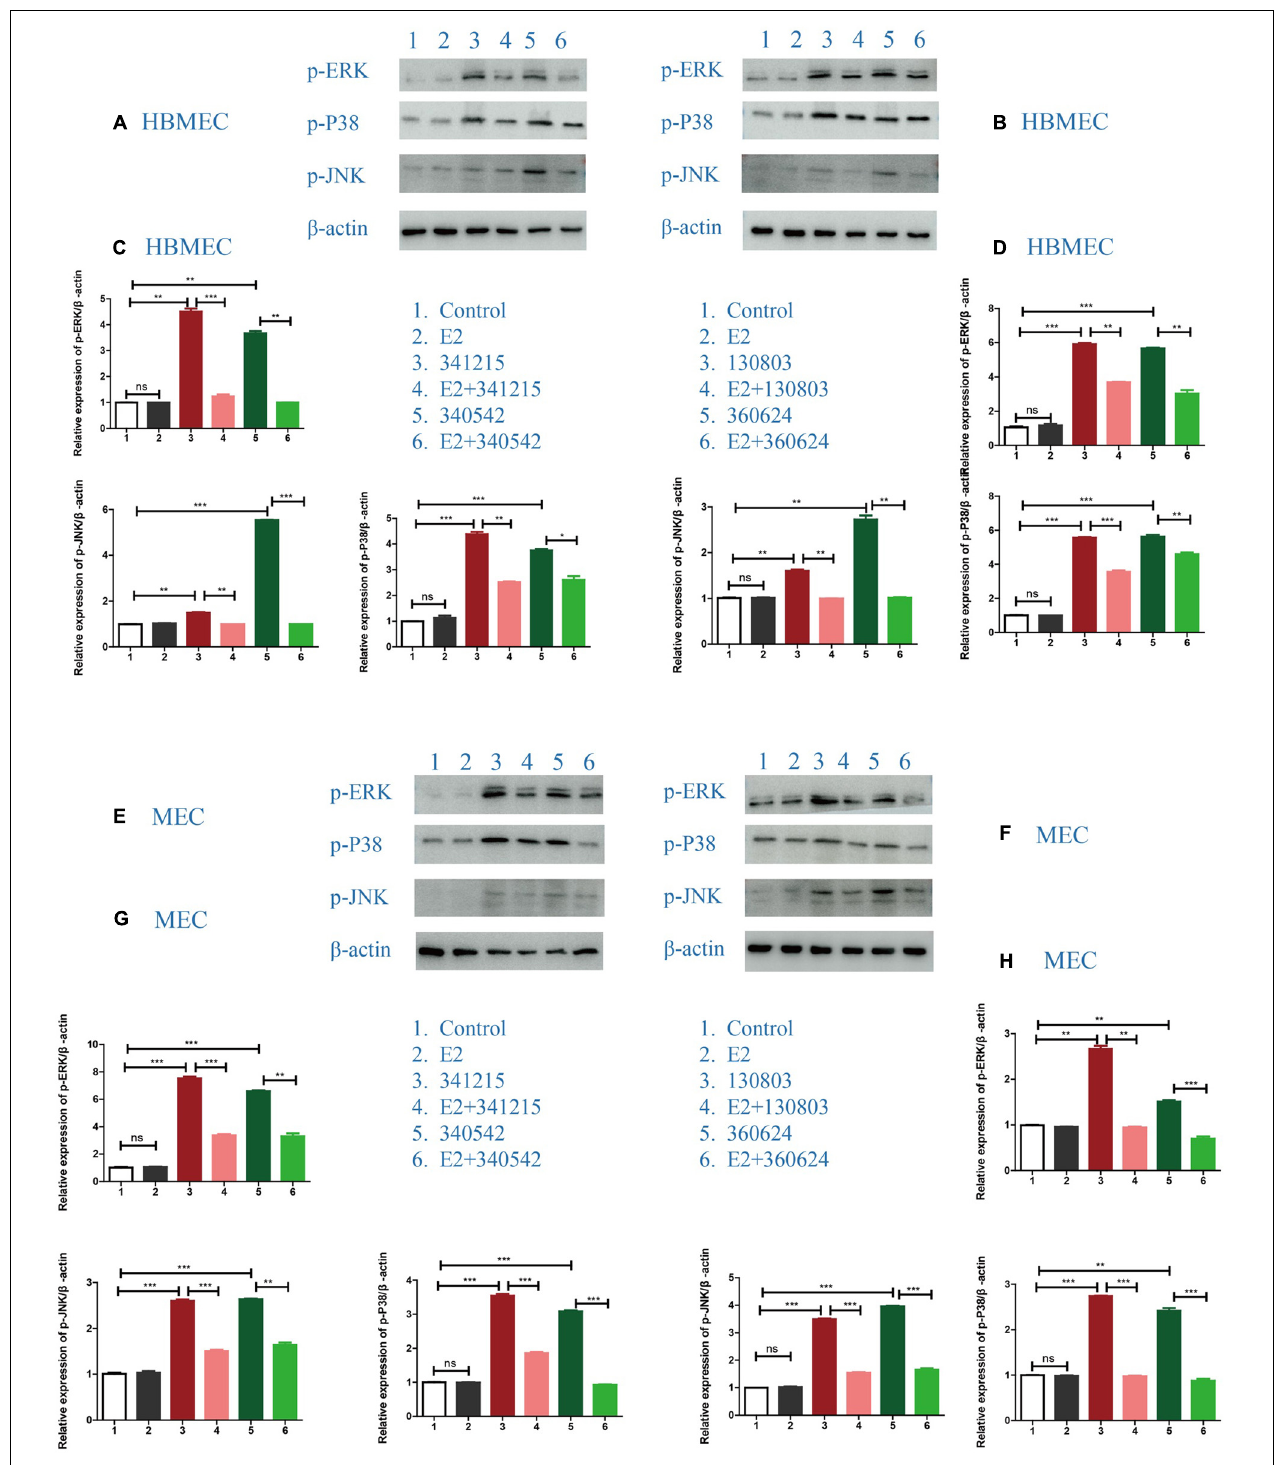
FIGURE 3 | The effect of E2 on the MAPK signaling pathway in Neisseria meningitidis -infected cells. (A,B) HBMECs were treated with N. meningitidis isolates 341215 and 340542 (A) , 130803 and 360624 (B) . The levels of phosphorylated ERK, JNK, and P38, as MAPK downstream molecules, in host cells were detected using western blotting, with β -actin used as the control. (C,D) The changes of protein levels in HBMECs were analyzed using Image-J software, and the gray values were statistically analyzed using GraphPad Prism software. (E–H) The levels of downstream molecules of the MAPK pathway were detected by western blotting in MECs according to the above treatment scheme. * P < 0.05, ** P < 0.01, *** P <